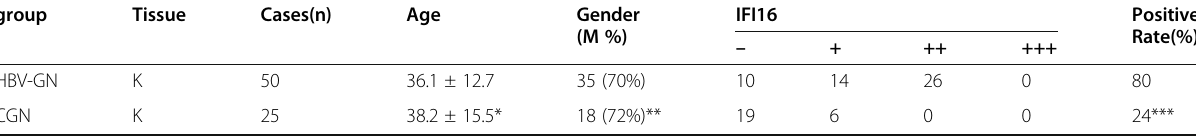
Table 3 Expression of IFI16 was significantly high in HBV-GN compared with CGN group Tissue Cases(n) Age Gender